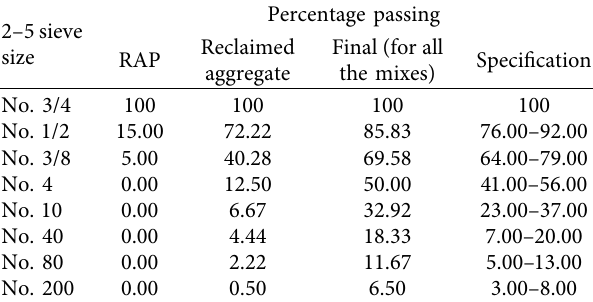
Table 3: Gradation of